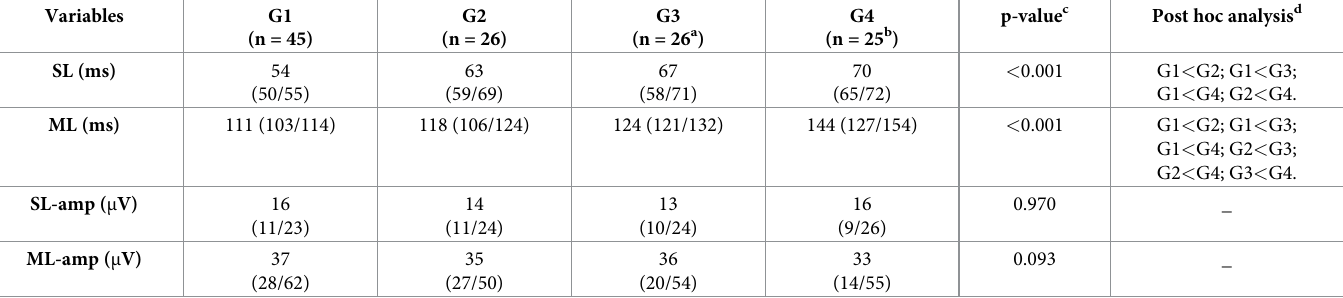
expressed as median (Quartil Q1/Quartil Q3) for continuous variables with non-normal distribution. a For SL data analysis, three cases with absent response were excluded. b For SL and ML data analysis, 15 and 11 cases with absent responses were excluded, respectively.